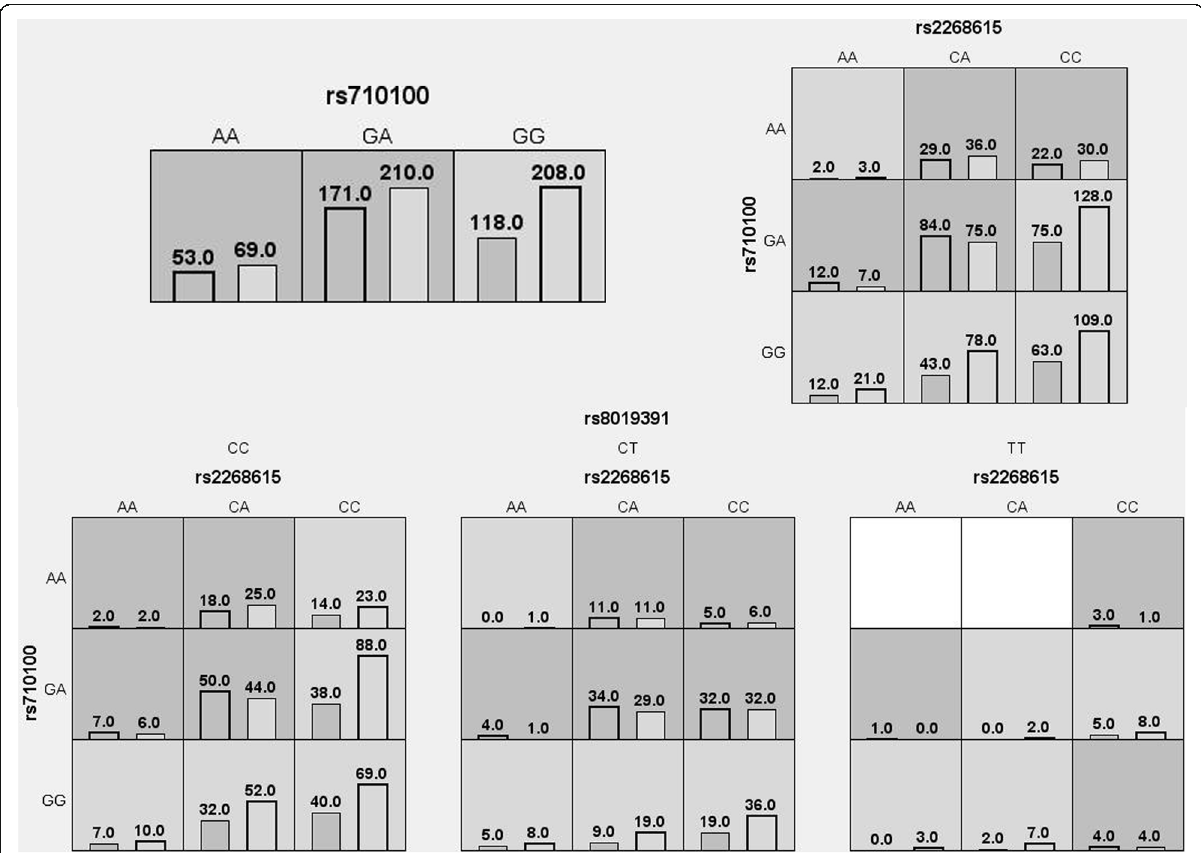
Fig. 1 Summary of MDR gene-gene interaction. Each cell shows counts of “ case ” on left and “ control ” on